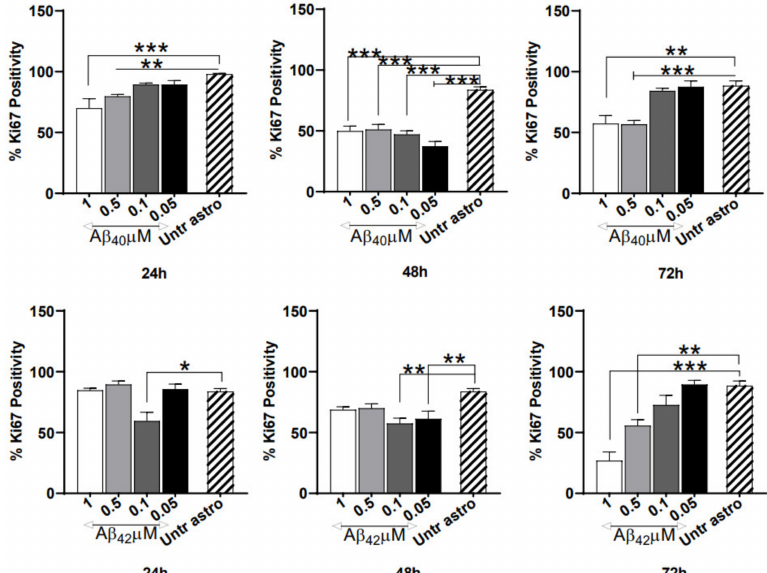
Figure 5. ACM displays an anti-proliferative effect on NGC0211 cells. Astrocyte-conditioned medium (ACM) was obtained after treating astrocytes (7 × 10 4 cells/well, 24 well plates) with A β 40/42 peptides (1, 0.5, 0.1, 0.05 µ M), inflammatory molecules (TNF α 20 ng/mL, IL1- β 2 ng/mL), or left untreated (control) for 24 h. ACM was used to treat NGC0211 cells (0.5 × 10 4 cells/well, 16-well chamber slide) for 24 h. Cells were then fixed, stained with mouse anti-human Ki67 antibody (1:100 dilution; clone MIB-1, DAKO, Denmark) followed by incubation with secondary Alexa-488-conjugated anti-mouse antibody (1:500 dilution, Invitrogen). The slides were mounted using DAPI containing mounting medium. Slides were then imaged, and individually stained cells were counted. Data are represented as mean ± S.E ( n = 3). The quantification of Ki67-positive cells was based on the evaluation of at least 500 cells/well. Statistical analysis using one-way ANOVA analyses and additional Tukey’s Multiple Comparison Test was performed to compare control and treated groups. * p < 0.05, ** p < 0.01, and *** p <